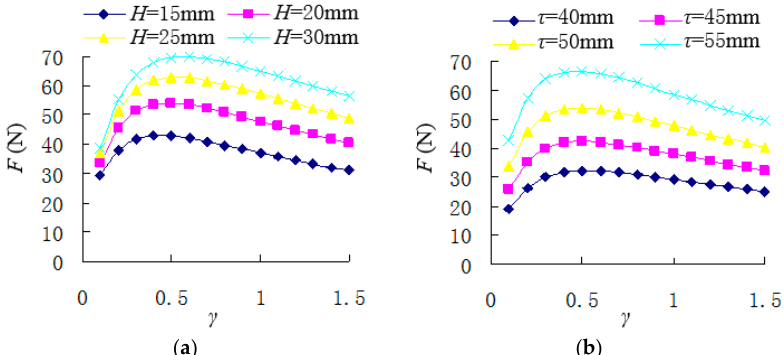
Figure 6. Force characteristic versus parameter γ : ( a ) with different H when τ = 50 mm; ( b ) with different τ when H = 20